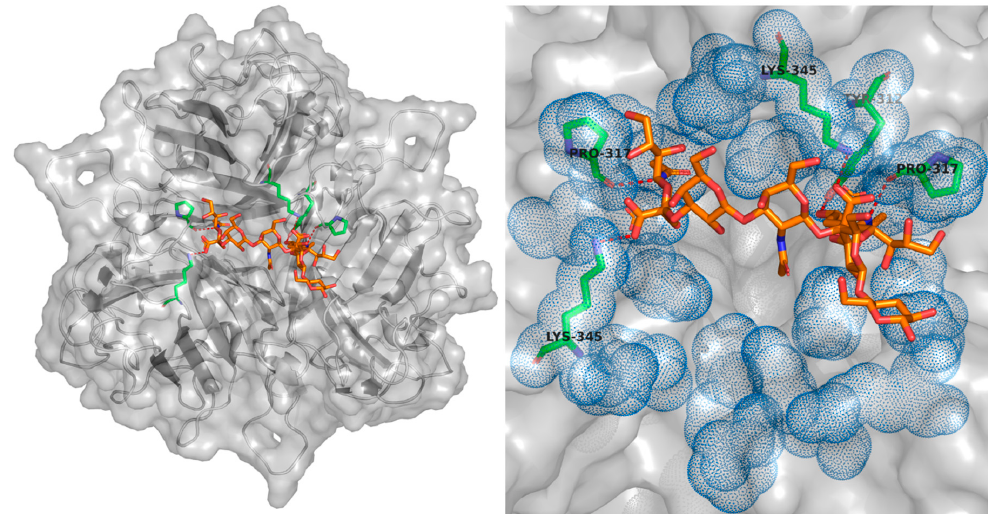
Figure 6. GD1a/Sialic Acid interacting residues within the Ad37 fiber knob domain. Key residues forming the GD1a-Ad37Fkn interaction are shown as green sticks, with the GD1a in orange, hydrogen bonds are shown by red dashes. While the interface can occur in three orientations, only one set of interacting residues is shown. The blue dots show the surface of all residues shown to be able to interact with GD1a or support the interaction, seen to create a large apical binding pocket. Structure from PDB: